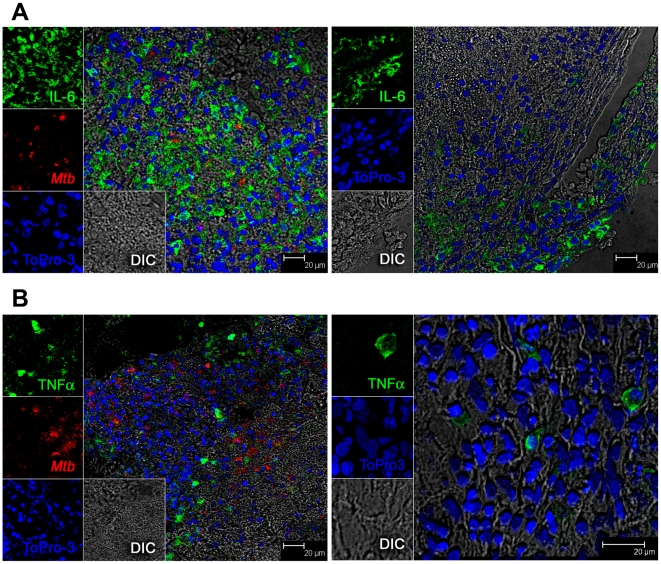
Confirmation of transcriptome results by confocal microscopy.Confocal microscopy shows differential expression of pro-inflammatory cytokines IL6 (A) and TNFα (B) in week 4 (left panels) and week 13 (right panels) lesions. Immunofluorescence was performed on tissues obtained from two animals – one “early” and one “late” animal.